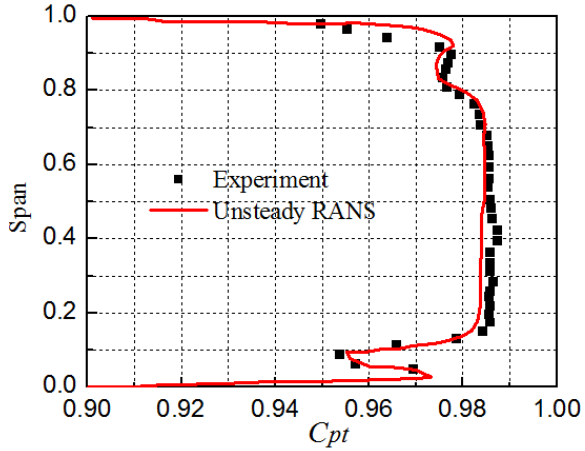
Figure 3. Pressure coefficient change at the monitoring point.